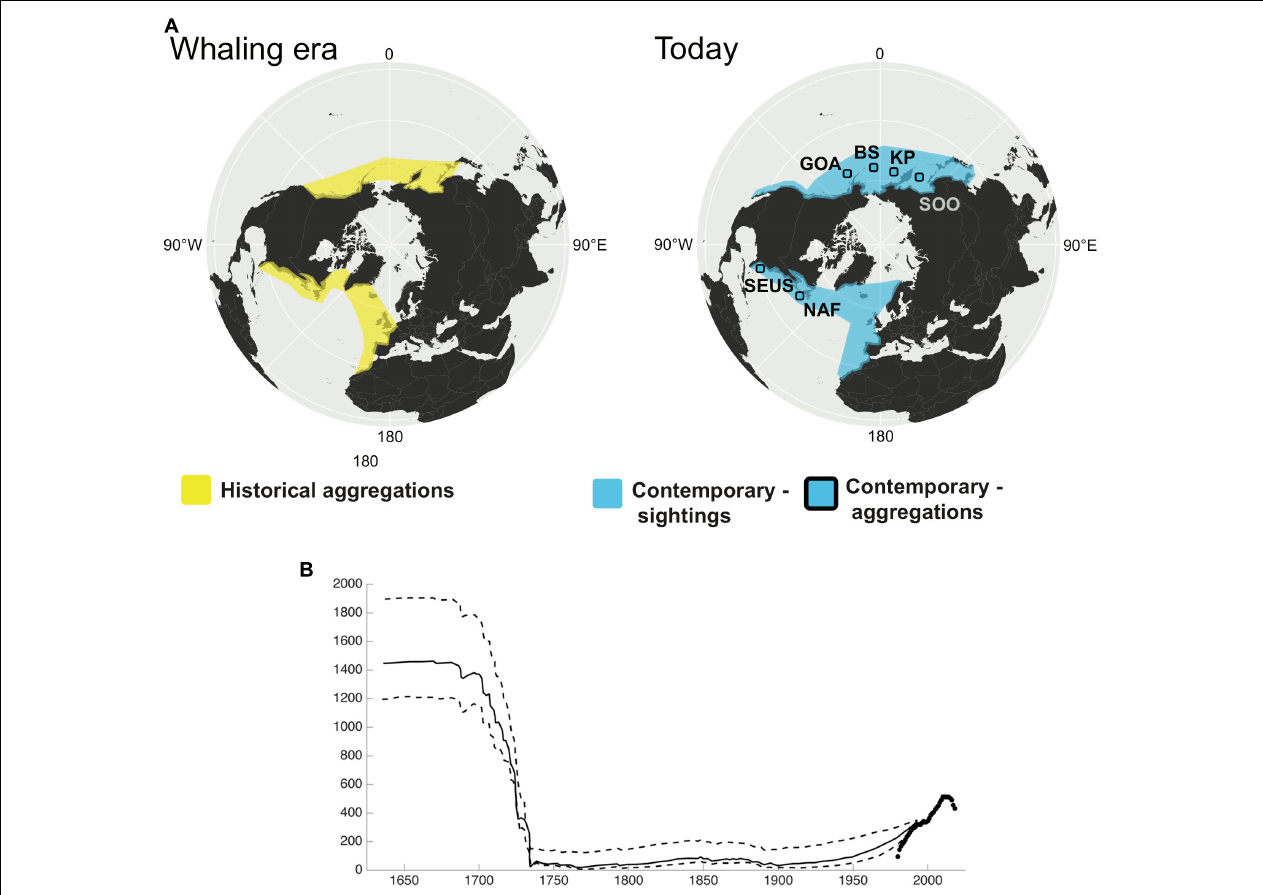
FIGURE 2 | (A) Change in distribution of North Pacific and North Atlantic right whales. The North Pacific right whale was hunted across the North Pacific, although the whaling grounds were primarily summering grounds and no wintering areas were identified. This mystery continues today, as the contemporary distribution of these two stocks are characterized by small aggregations seen in summer feeding grounds in the Gulf of Alaska (GOA) and southeast Bering Sea (BS) in the east, and the Sea of Okhotsk (SOO) and the Kamchatka Peninsula (KP) in the west. The North Atlantic right whale was hunted around the New England coast during spring months in the northwest Atlantic, and around the southeast United States coast during winter. Whales were occasionally seen and killed north of New England up to Greenland. In the northeast Atlantic, the species was found off Greenland, Iceland and the United Kingdom in the summer months, and the Bay of Biscay and Cintra Bay, Western Sahara, during the winter. There are now no regular aggregations in the northeast Atlantic, although there are occasional sightings. In the northwest Atlantic, there is a well-described winter calving ground off the coast of Florida and Georgia, United States (SEUS), and summer feeding grounds around the Bay of Fundy and Nova Scotia, off the coast of North America (NAF). The North Pacific and North Atlantic right whales are, by IWC convention, divided into east and west stocks. Recent genetic data supports differentiation of eastern and western stocks of North Pacific right whales (Pastene et al., 2018). (B) Modeled population trajectory of North Atlantic right whales off the eastern United States, with Maximum Sustainable Yield rates of 0.03 (solid line) and 0.01 and 0.05 (dashed lines; modified from Reeves et al., 1992). Black points are from modern observations of the minimum number alive from the North Atlantic right whale catalog (NARWC,